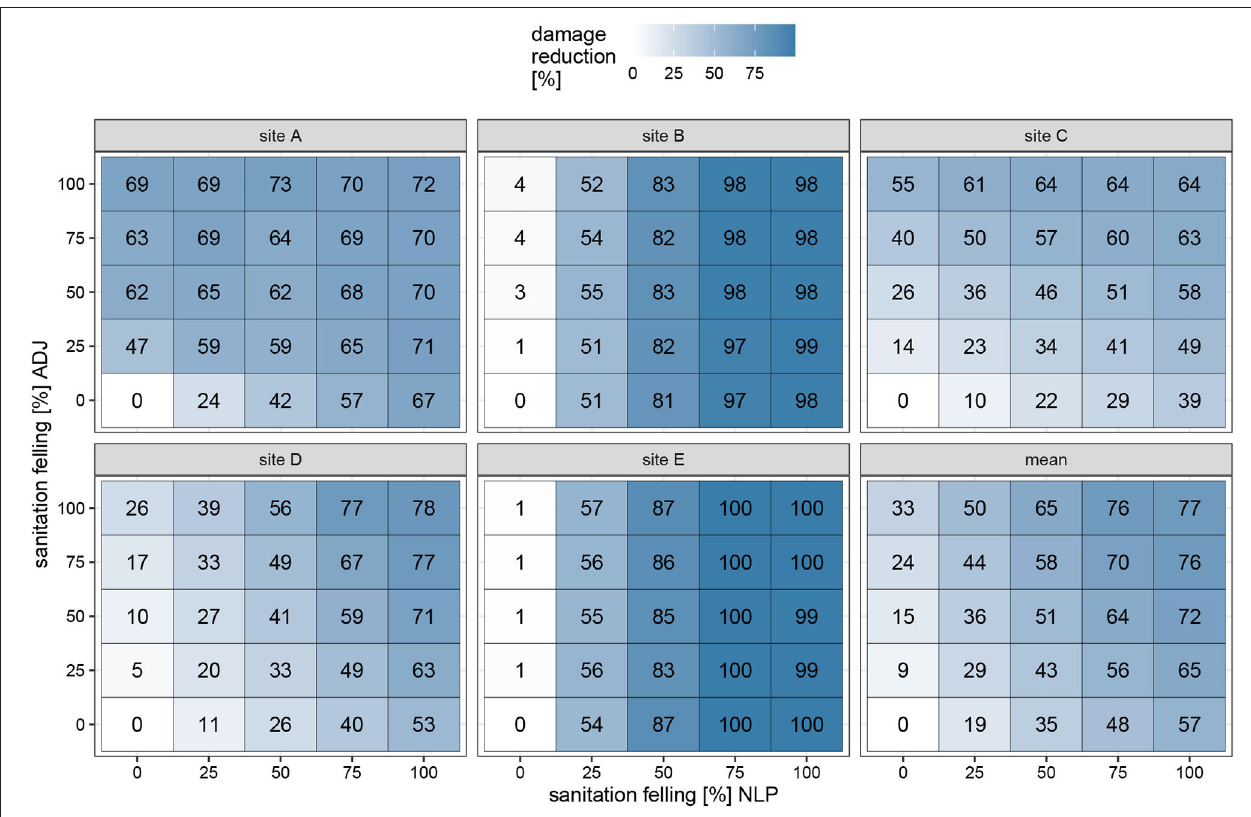
FIGURE 6 | Mean effectiveness of reduction of damaged trees outside the NLP [%] of the 40 repetitions in dependency of sanitation felling intensity inside the NLP (x axis) and outside the NLP (y axis). Each panel displays the effects on one of the five research sites and the mean over all sites combined. The effectiveness is calculated following ( Abbott,